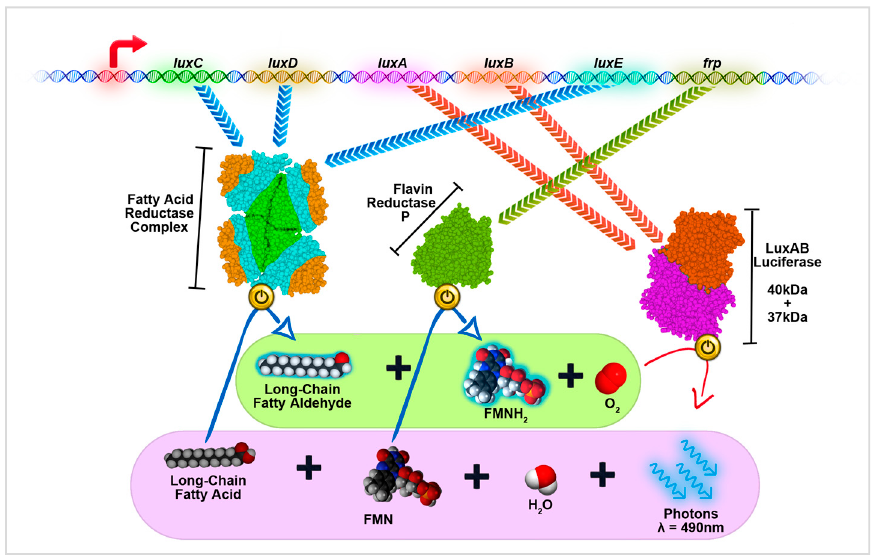
Figure 2. Schematic of a self-contained Lux operon system. The lux operon usually contains five different genes: luxC , luxD , luxA , luxB , and luxE . These five genes constitute the wildtype version of lux operon that can be found in Photorhabdus luminescens ; this figure shows the modified version of lux operon that contains an additional frp gene for better operational efficiency when expressed in certain organisms. luxA and luxB code two subunits for dimeric LuxAB luciferase; luxC , luxD , and luxE code relative enzymes, which can form a dodecamer protein complex to produce fatty aldehyde substrate for LuxAB; and frp gene codes the Flavin reductase P that can be used to shift the natural cellular balance between FMN and FMNH 2 . In the presence of oxygen, LuxAB oxidizes fatty aldehyde and FMNH 2 to generate cyan luminescence ( λ = 490 nm). The oxidized products, fatty acid and FMN, can be recycled to re-form substrates. The continuous run of Lux system only requires the supplies of ATP, NADPH, and oxygen, so it is self-contained and able to constantly produce luminescence as long as the host cell is alive.